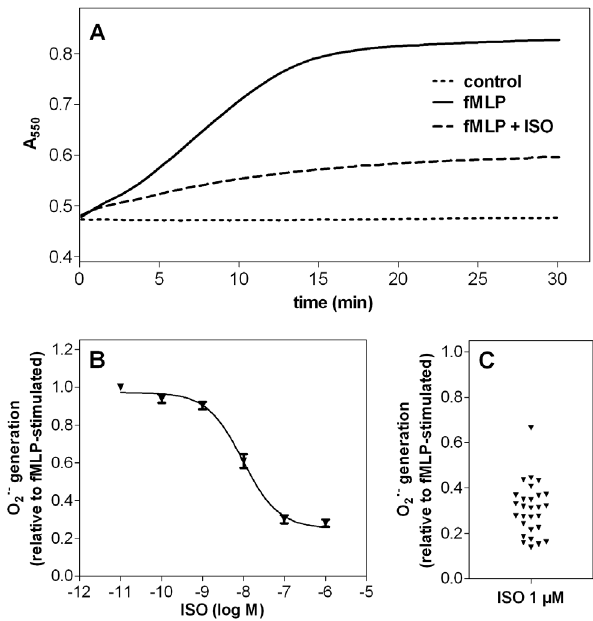
Figure 1. Superoxide anion generation assay (O 2 N 2 assay). The O 2 N 2 production in human neutrophil granulocytes (1 6 10 5 cells per well) was monitored by measuring the superoxide dismutase-inhibit- able reduction of ferricytochrome c at 550 nm as described under Materials and Methods . ( A ) Continuous measurement of O 2 N 2 produc- tion for 30 min under control conditions (control), after stimulation with 1 m M fMLP (fMLP) and in the presence of 1 m M fMLP in combination with 1 m M ISO (fMLP + ISO). Data shown are from one representative experiment performed in triplicate. ( B ) Concentration-response curve for ISO in the O 2 N 2 assay. Data shown are from nine independent experiments, performed in triplicate (data points are means 6 S.E.M.). Data were analyzed by non-linear regression and were best fitted to sigmoidal concentration/response curve. ( C ) Inter-experimental vari- ability of inhibitory effect of 1 m M ISO on fMLP-stimulated O 2 N 2 production. Each data point represents one independent experiment. Increase in absorbance at 550 nm during 30 min after addition of fMLP was set to 1.00 and increase in absorbance in the presence of 1 m M ISO ( + fMLP) in each assay was compared to this value.